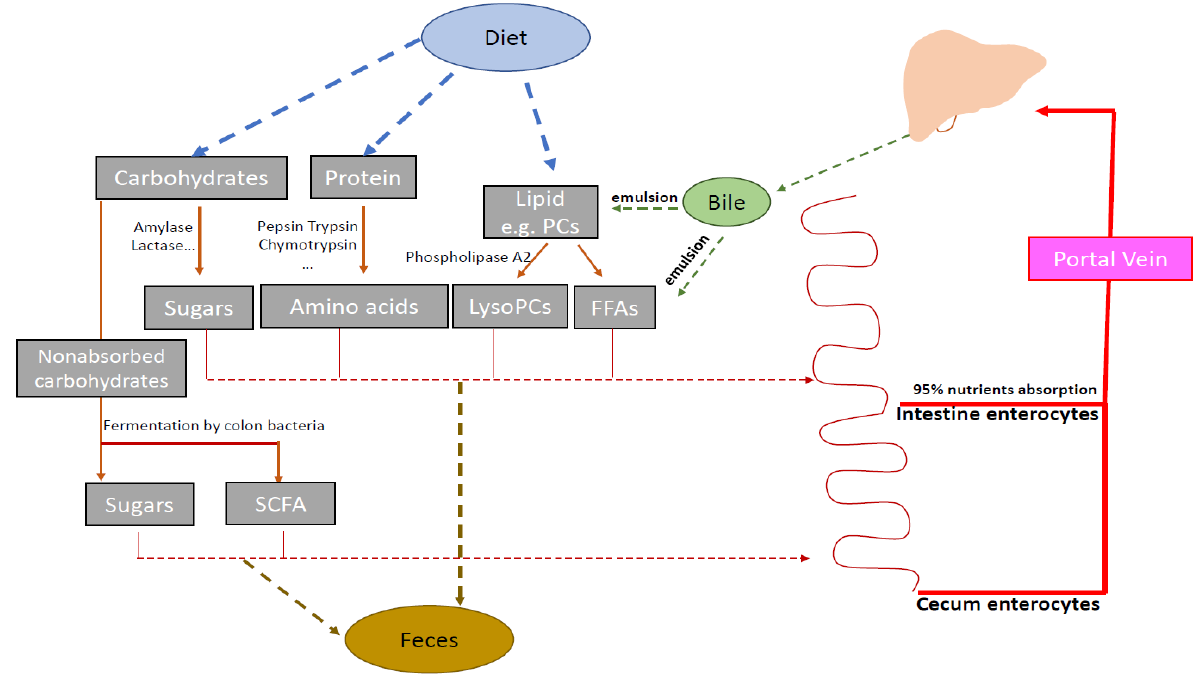
Figure 5. Nutrition digestion and absorption in the gut.